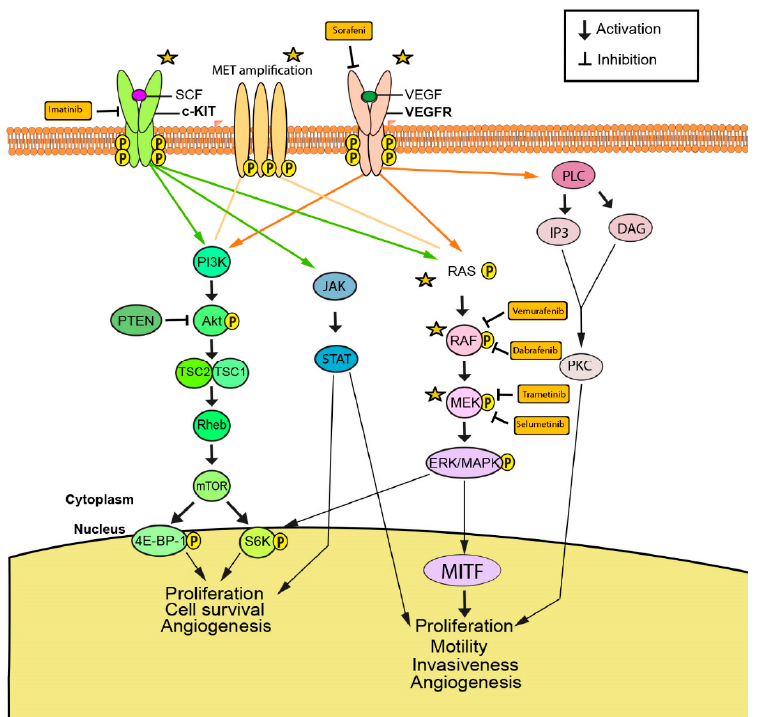
Figure 1. Predominant signaling pathways contributing to melanomagenesis and progression. Phosphorylation of receptor tyrosine kinases mesenchymal epithelial transition factor (c-MET), receptor-tyrosine kinase Kit (c-KIT) and vascular endothelial growth factor receptor (VEGFR) initiates signaling pathways resulting in proliferation, survival, motility, and angiogenesis. Activating mutations in downstream pathway components, such as reticular activating system (RAS), rapidly accelerated fibrosarcoma (RAF), and mitogen-activated protein kinase (MEK), confer constitutive pathway activation despite absence of growth signals [40–42]. Activation of epithelial mesenchymal transition (EMT) has been implicated in acquired resistance to multiple drugs that target aberrant